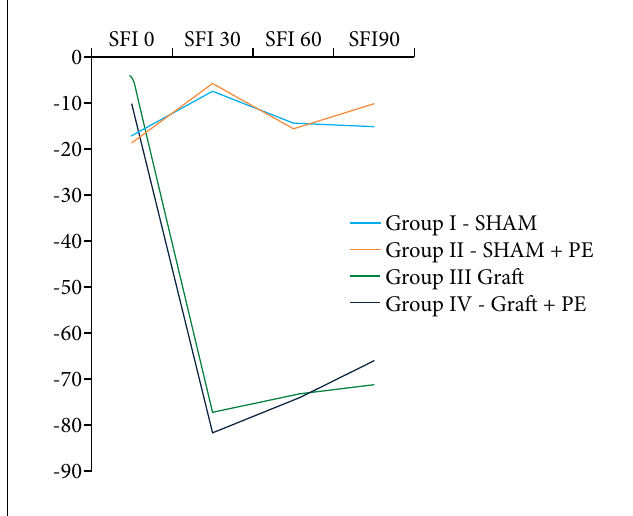
Figure 3 - SFI Average at 0, 30, 60 and 90